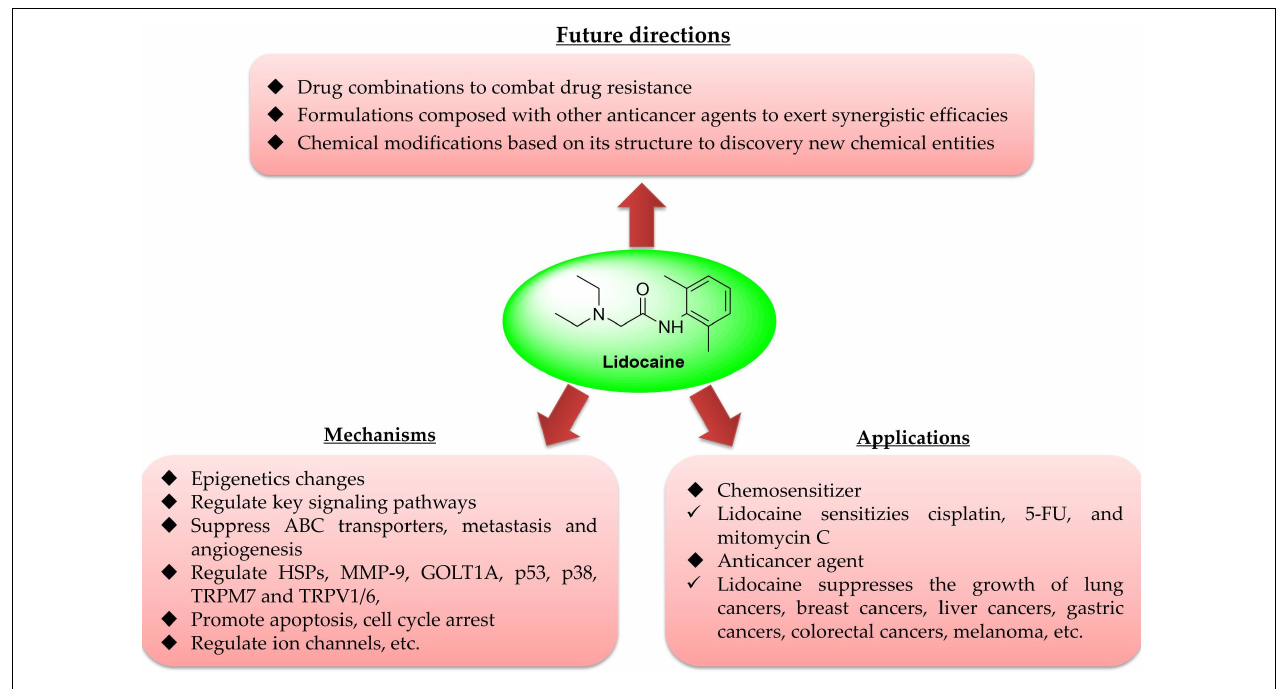
FIGURE 2 | Overview of lidocaine in cancer treatment.